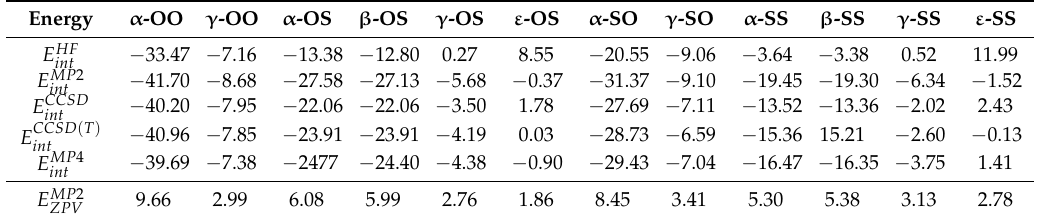
Table 3. Supermolecular interaction energies calculated with various methods and zero-point energy (ZPE) correction using the aug-cc-pVDZ(-PP) basis set and harmonic